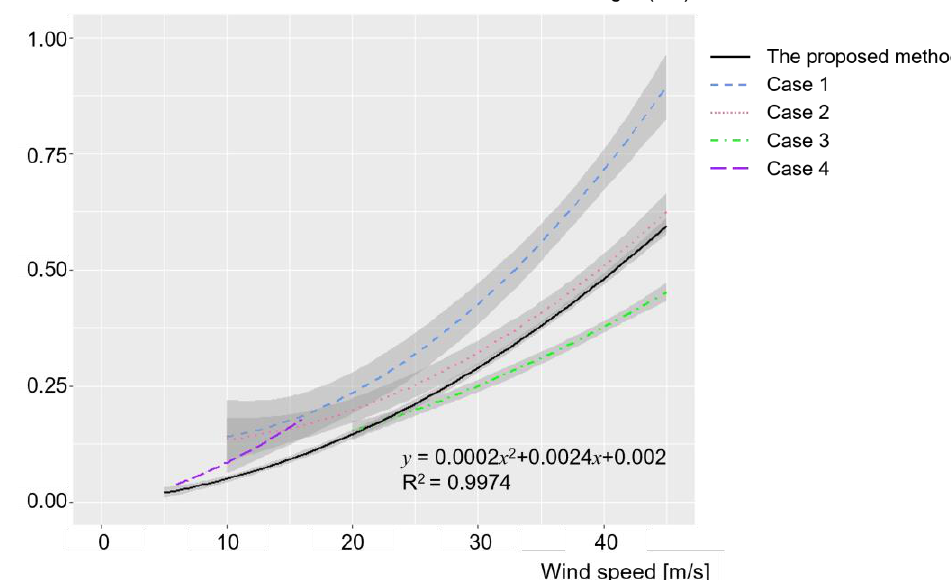
Figure 10. The comparison results for the ratio between the maximum deflection and tree height under varying wind